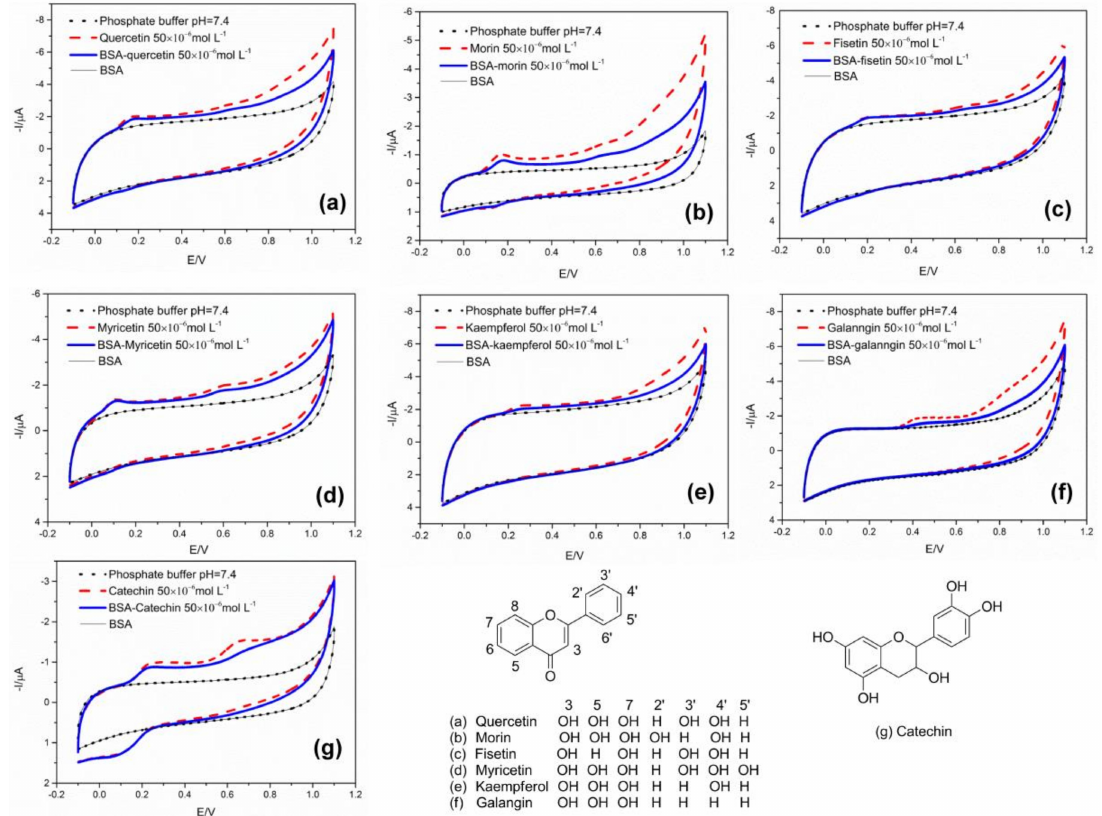
Figure 1. The structures of investigated flavonoids and their cyclic voltammetries (CVs) before (red line) and after (blue line) binding to bovine serum albumin (BSA), ( a ): quercetin, ( b ): morin, ( c ): fisetin, ( d ): myricetin, ( e ): kaempferol, ( f ): galangin, ( g ):